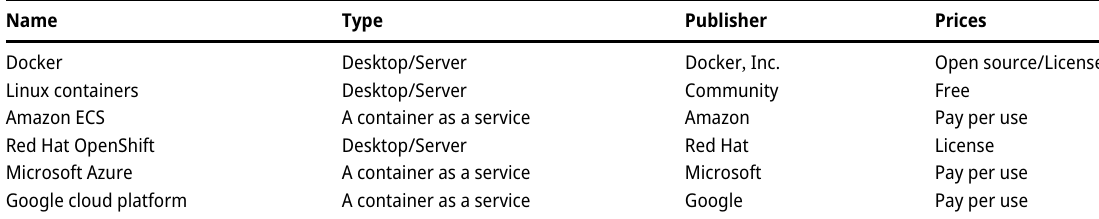
Table 2: Some examples of container